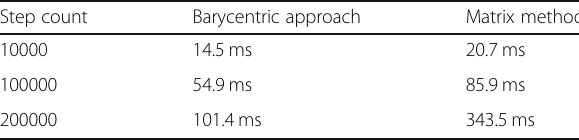
Table 1 Performance measurements of the